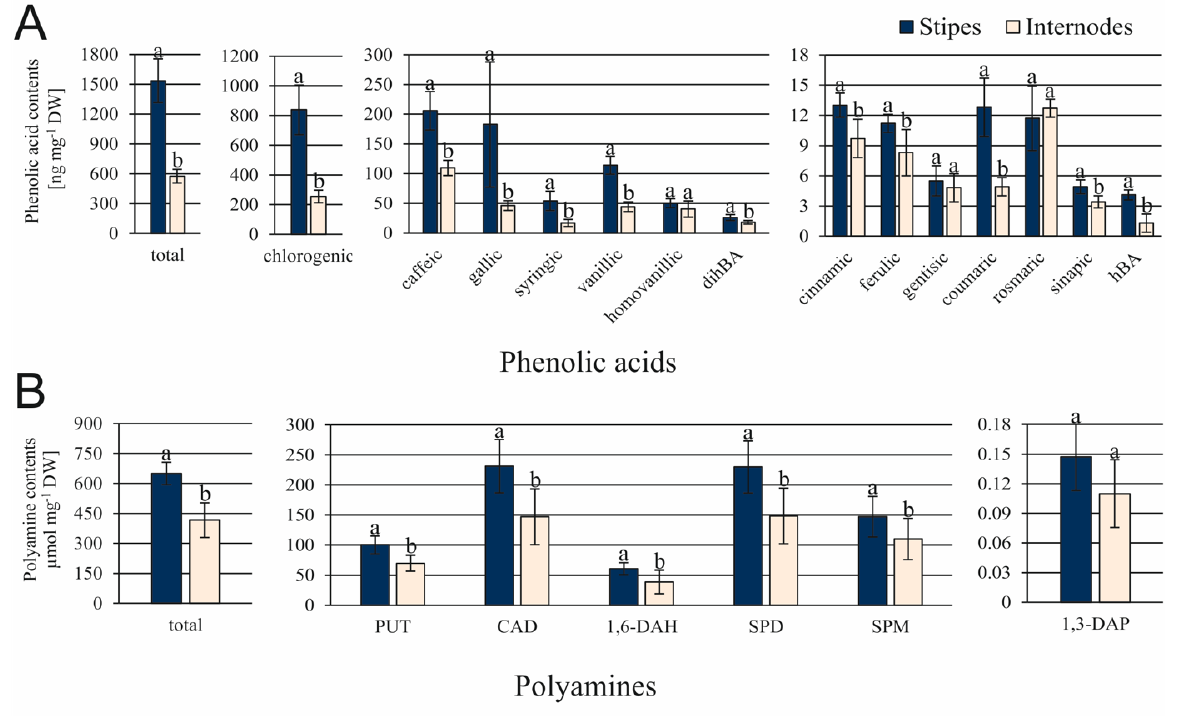
Figure 5. Contents of phenolic acids ( A ) and polyamines ( B ) in stipe and internode explants of C. delgadii . Values represent the means ± standard deviation (SD) of 6 independent replicates. The Student’s t -test was used to estimate statistical significance of results for each type of compounds. Data followed by different letters (a, b) were significantly different at p < 0.05.